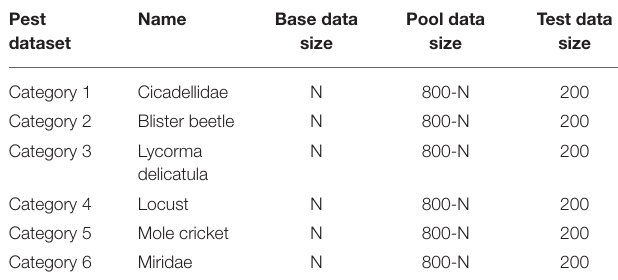
TABLE 1 | Details of the used pest dataset.